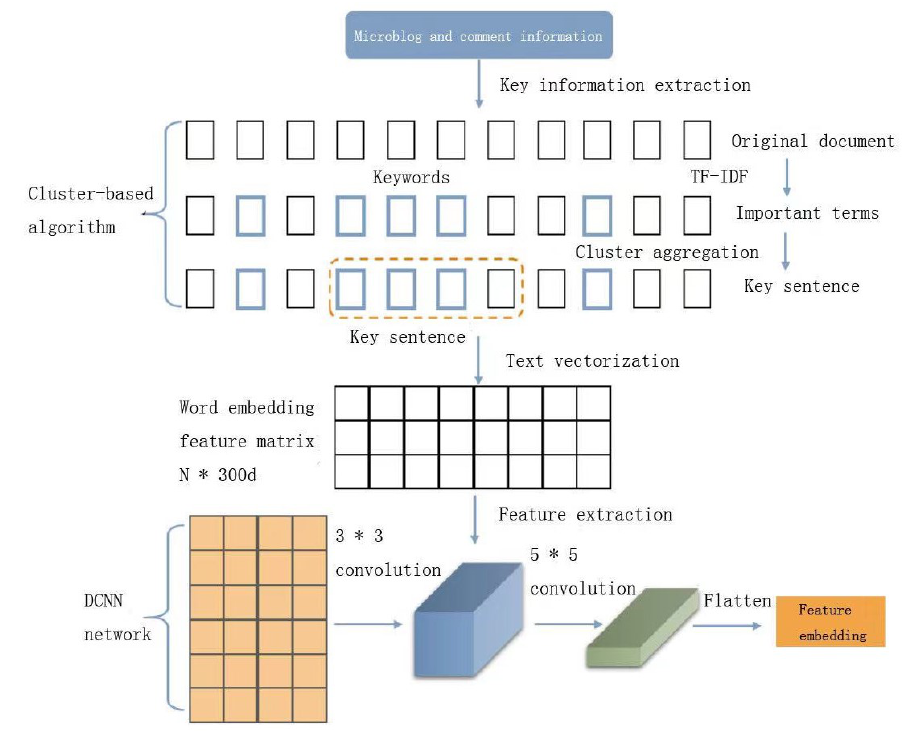
Figure 3. The learning of group comment